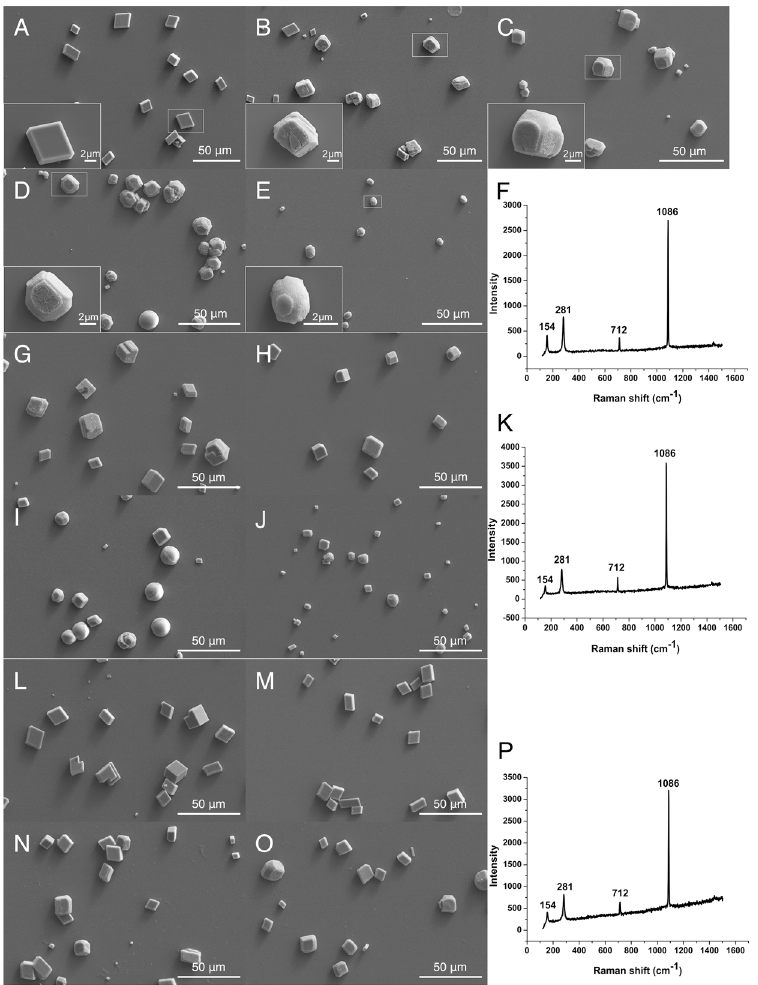
Fig 5. SEM images of in vitro crystallization of calcite in the presence of rKRMP-3, rBR, rGYR and Raman spectrum analysis of crystals. Crystals were grown in the presence of 40 μ g/ml GST (A), 2 μ g/ml rKRMP-3 (B), 10 μ g/ml rKRMP-3 (C), 20 μ g/ml rKRMP-3 (D), 40 μ g/ml rKRMP-3 (E), 2 μ g/ml rBR (G), 10 μ g/ ml rBR (H), 20 μ g/ml rBR (I), 40 μ g/ml rBR (J) and 2 μ g/ml rGYR (L), 10 μ g/ml rGYR (M), 20 μ g/ml rGYR (N), 40 μ g/ml rGYR (O). The crystals in left bottom of the image are enlarged images of the boxed part, respectively. F, K, P showed the raman spectra of the crystals from 40 μ g/ml rKRMP-3 (E), 40 μ g/ml rBR (J), 40 μ g/ml rGYR (O),